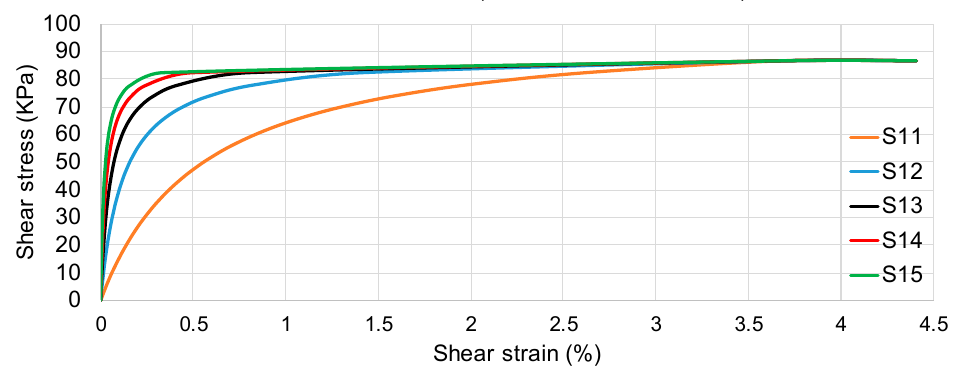
Figure 6. Backbone curve (S1 soil).